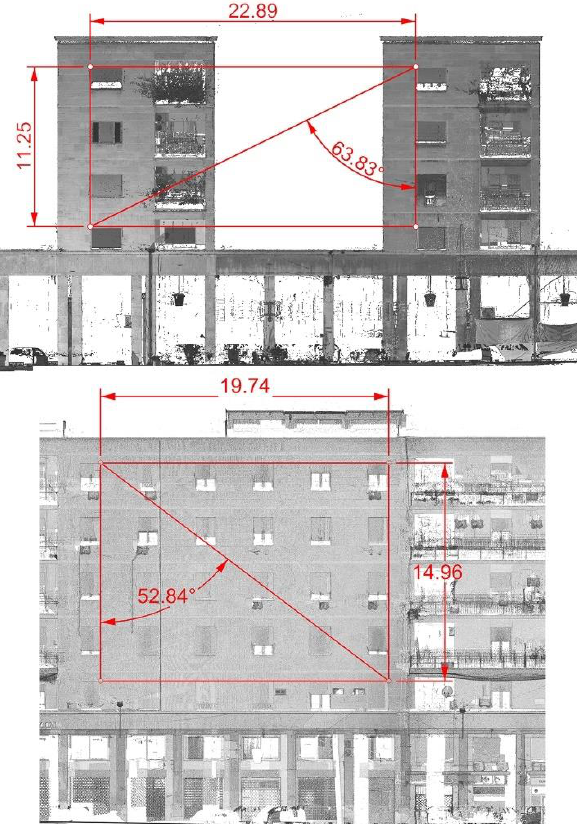
Figure 8: Rectangles and angles from the left (above) and right front (below), extracted from the laser scanning point